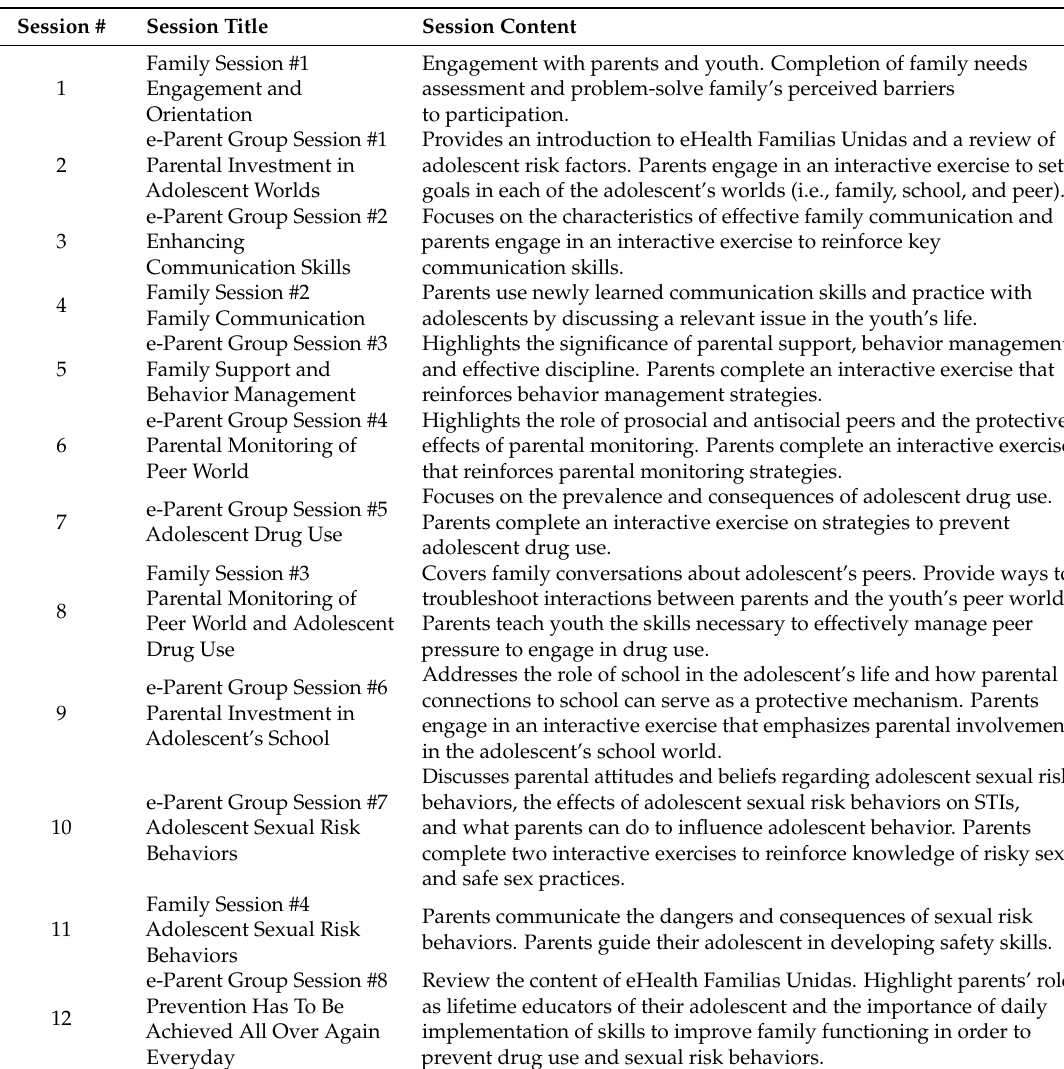
Table 1. eHealth Familias Unidas session